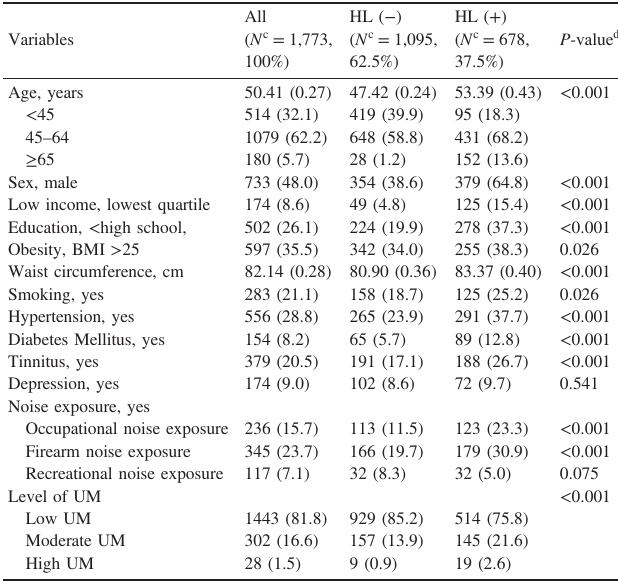
Table 1. Sociodemographic, systemic health, noise exposure, and unilateral mastication (UM) a data according to